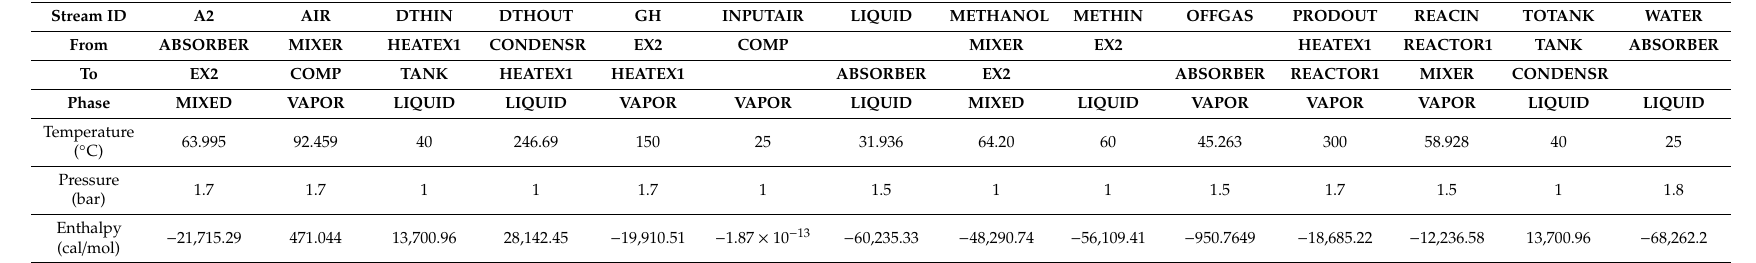
Table 3. Energy balance of Molybdenum-based